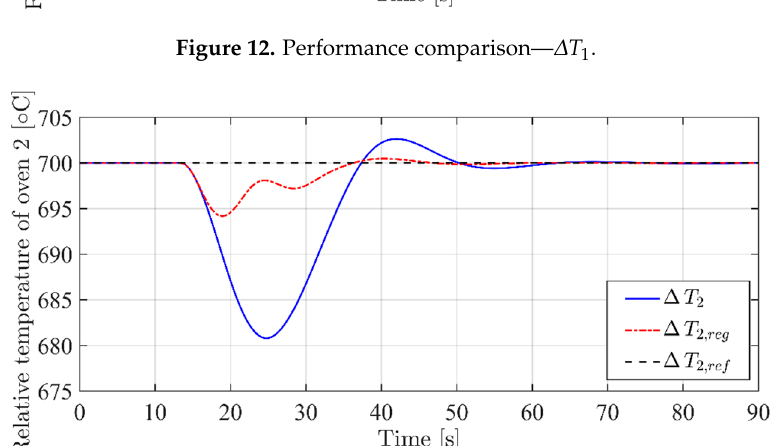
Figure 13. Performance comparison— 𝛥𝑇 (cid:2870)